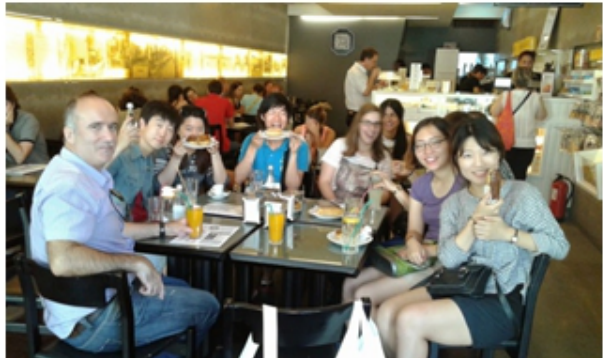
Figure 3. E4SD: Having a snack at the Leitaria da Quinta do